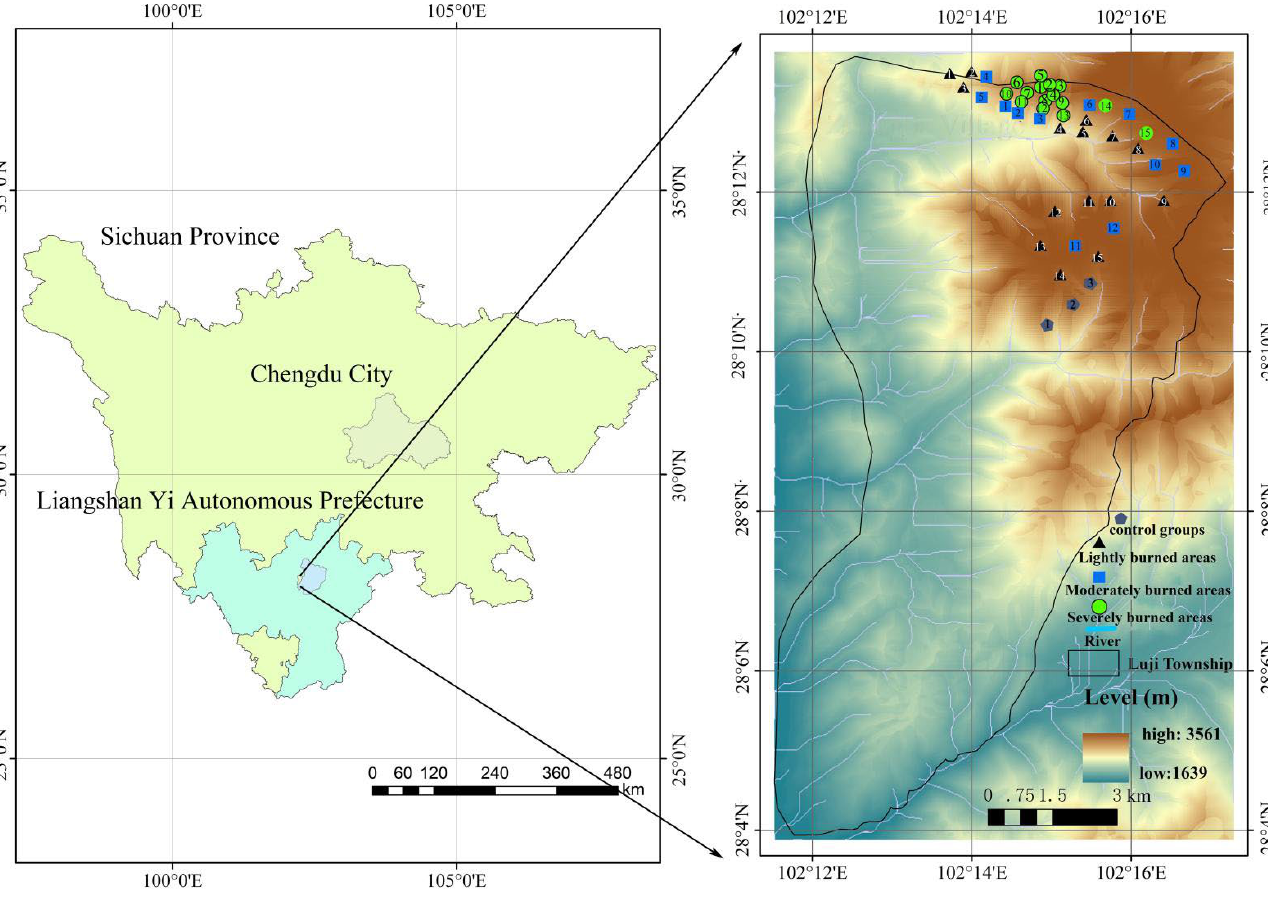
Figure 1. Study area.